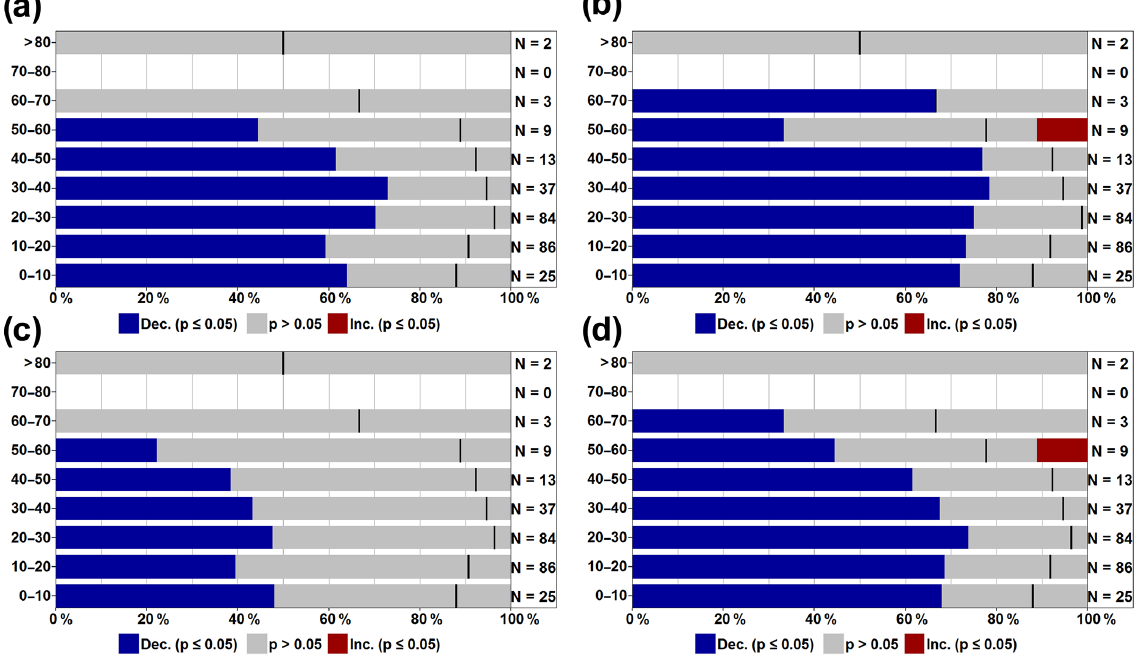
Figure 8. Proportion of monitoring sites with 2010–2014 average annual NO 2 concentrations (NO 2AA ) in 10µgm − 3 bins that had significant decreasing (blue), significant increasing (red) ( p ≤ 0.05), and non-significant trends (grey) in NO 2AA between 2000 and 2014, calculated us- ing (a) non-parametric Theil–Sen statistic and Mann–Kendall test, (b) parametric ordinary least-squares linear regression, (c) non-parametric Theil–Sen statistic and block bootstrap resampling, and (d) parametric first-order autoregressive (AR(1)) model. The black line represents the division between decreasing and increasing trends within the non-significant